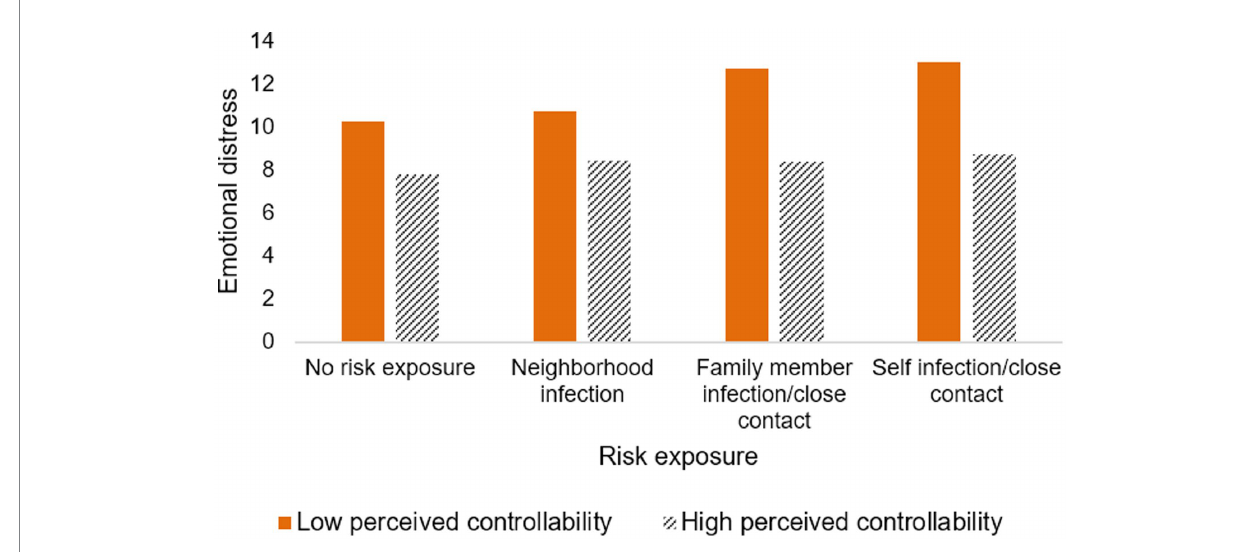
FIGURE 4 The interaction effect of risk exposure and perceived controllability on emotional